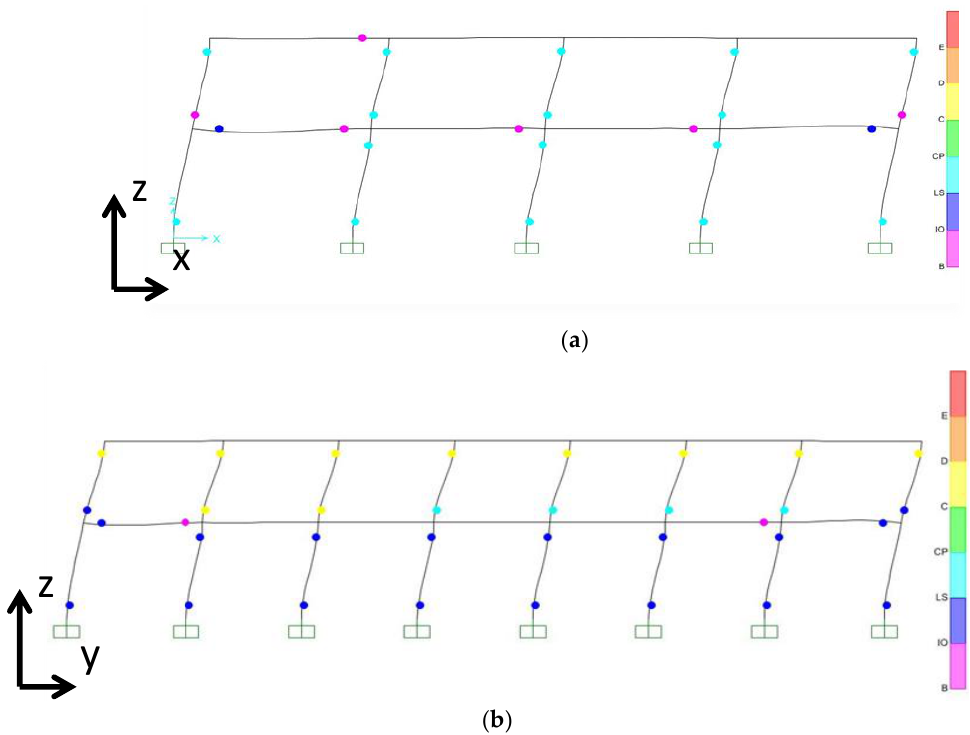
Figure 9. Plastic hinges of BM0 for a displacement level of 18.4 cm at the top of the building: ( a ) x-x direction; ( b ) y-y direction.